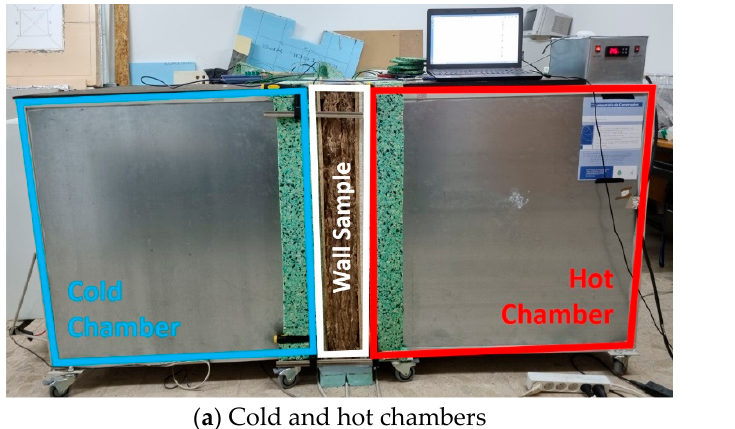
Figure 4. Experimental lab test illustrations.